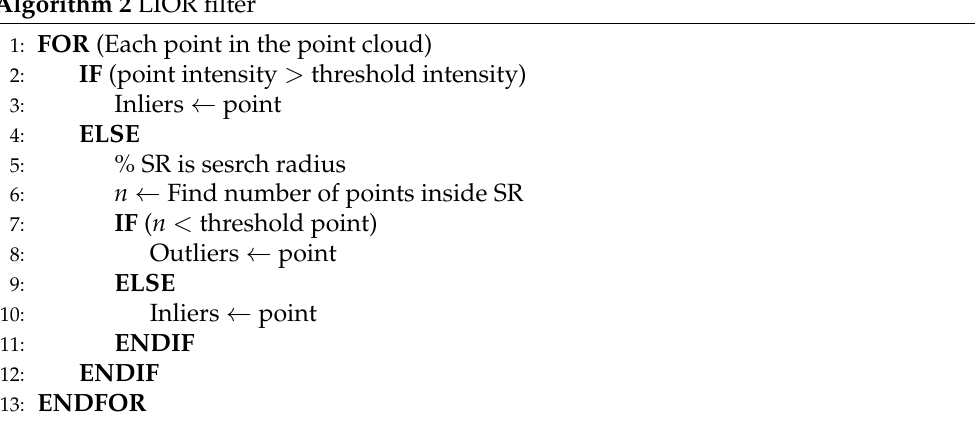
Algorithm 2 LIOR